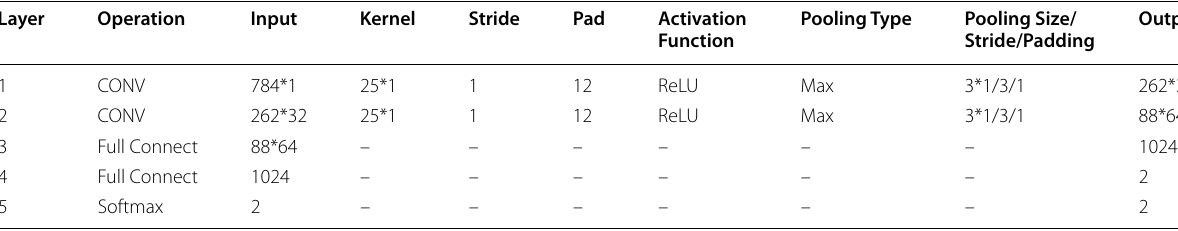
Table 1 CNN model